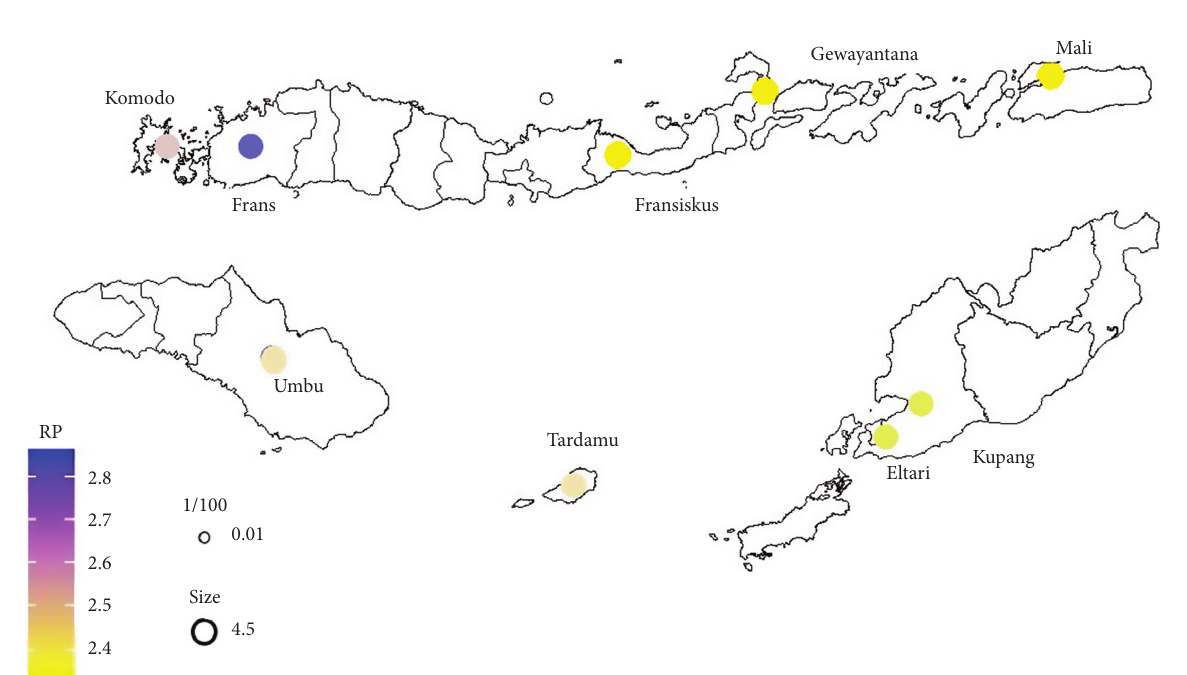
Figure 4: Mapping of drought return periods for 40% less rainfall than